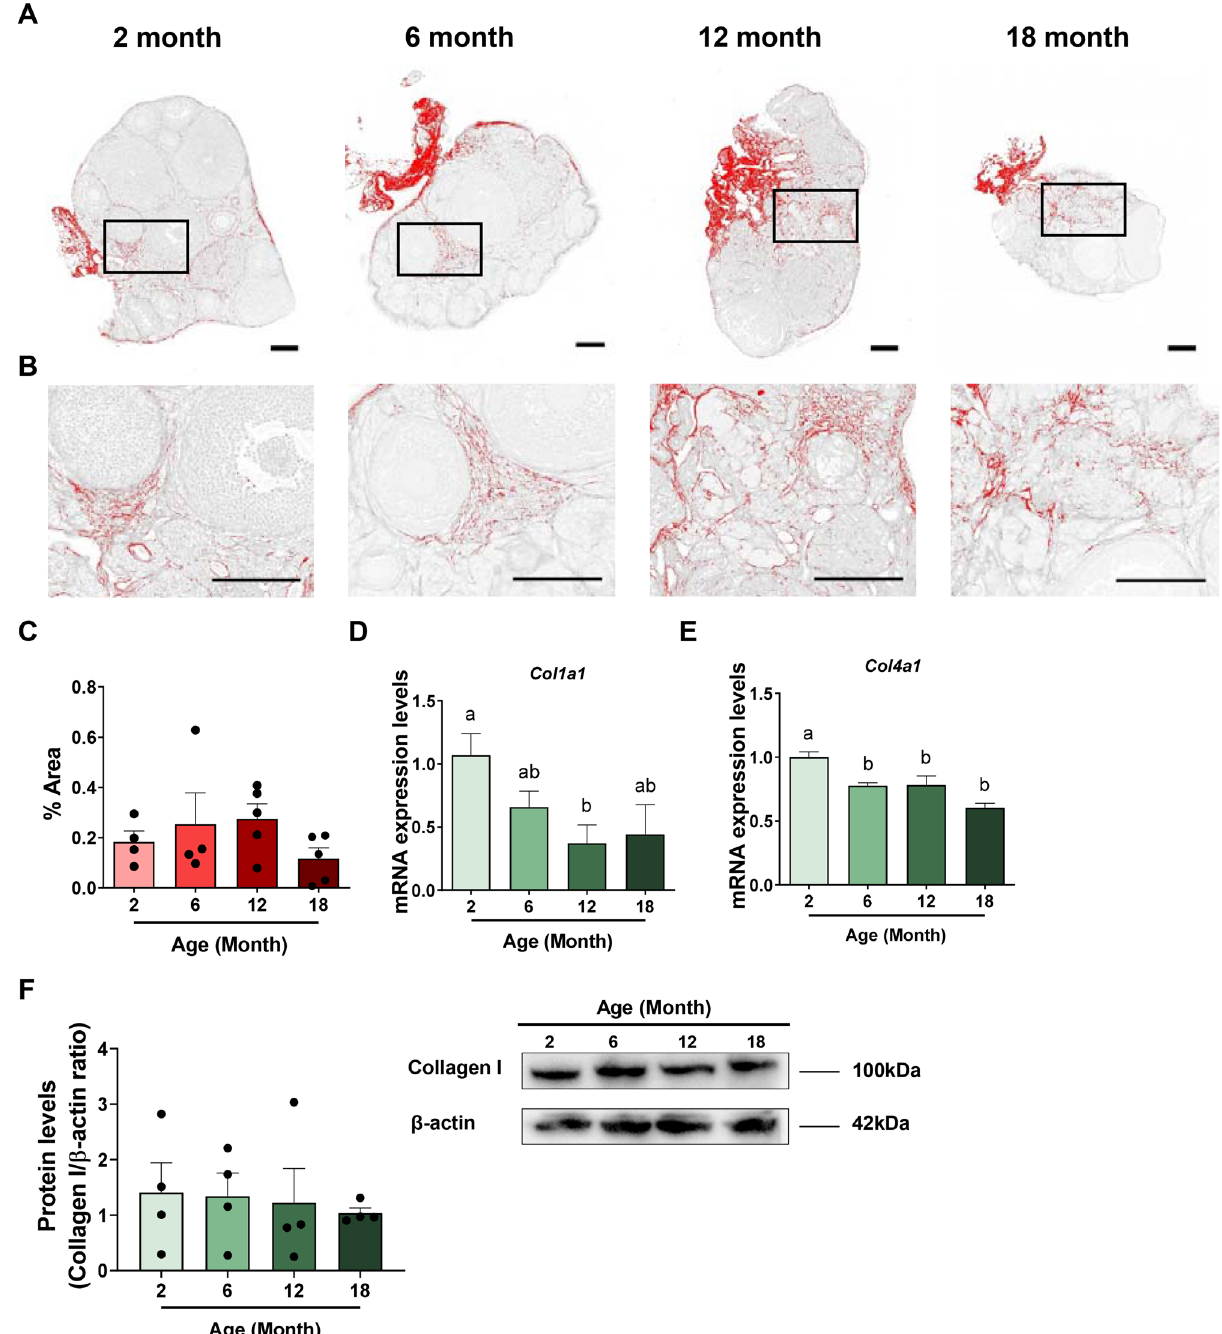
Figure 2. Evaluation of ovarian fibrosis during reproductive ageing. ( A ) Representative processed color threshold images of PicroSirius Red (PSR)-stained ovarian tissue sections used to quantify fibrosis in 2, 6, 12 and 18-month-old mice. ( B ) Higher magnification images from specific regions boxed in ovaries from 2, 6, 12 and 18-month-old mice. Scale bars are 200 μm. ( C ) Percentage of PSR-positive staining in ovaries from 2, 6, 12 and 18-month-old mice. n = 4–5 per cohort. Gene expression levels of Col1a1 ( D ) and Col4a1 ( E ) in ovaries from 2, 6, 12 and 18-month-old mice. n = 4–6 per cohort. ( F ) Quantification and representative image of ovarian protein levels of collagen I from 2, 6, 12 and 18-month-old mice. n = 4 per cohort. Data are presented as mean ± SEM; C: Kruskal–Wallis test, Dunn’s multiple comparisons test ( p > 0.05). ( D , E , F ): Ordinary One-way ANOVA, Tukey’s multiple comparisons test: a and b are significantly different among groups ( p < 0.05). Each dot represents one